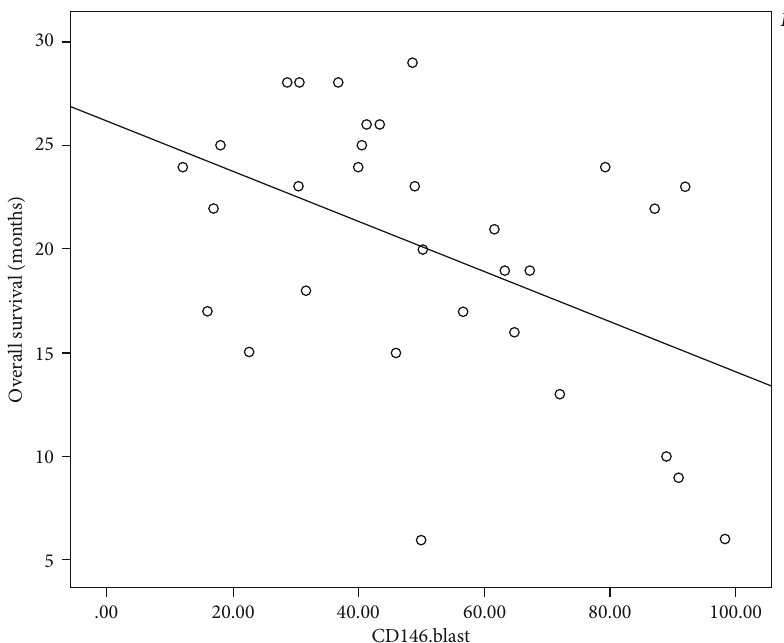
Figure 5: Scatter plot of the relation between CD146 + blasts and OS with 31 children with B-cell ALL.